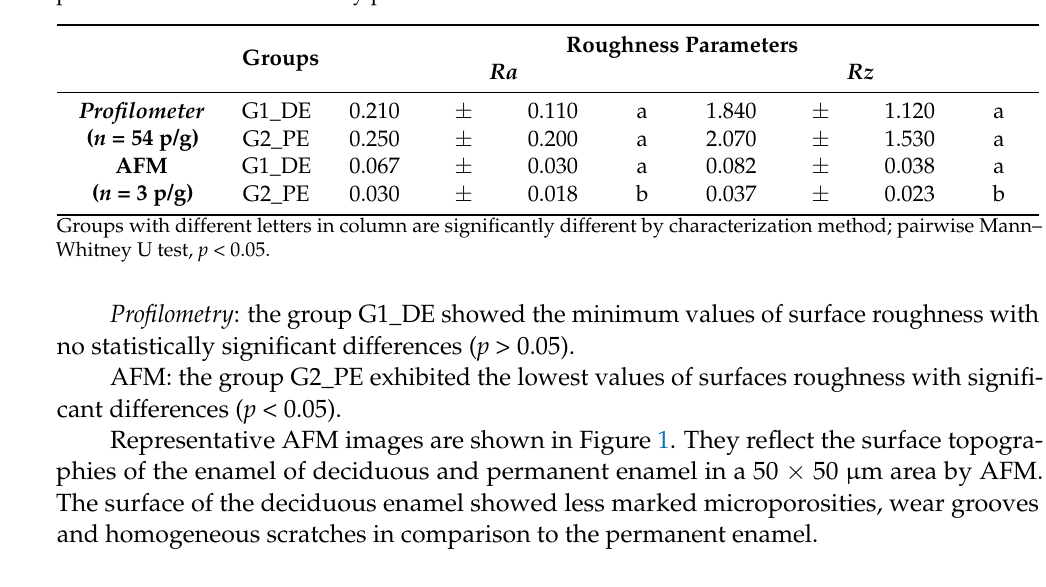
Table 1. Means and standard deviations of roughness parameters Ra and Rz ( µ m) of deciduous and permanent enamel obtained by profilometer and